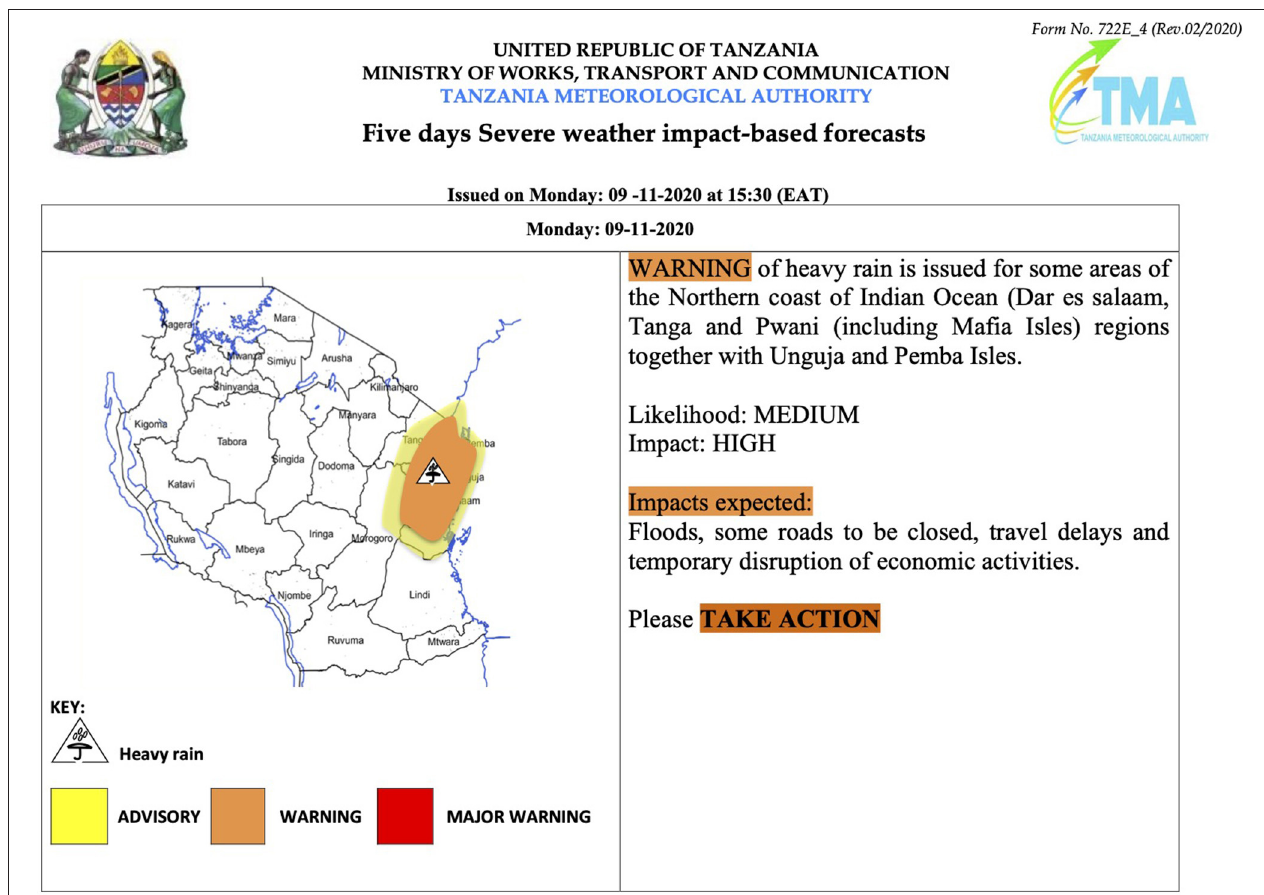
FIGURE 6 | An example of day 1 of a TMA severe weather impact-based forecast (Forecasting Division,